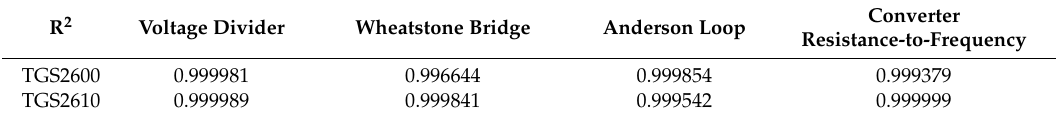
Table 2. Coe ffi cient of determination of model of each system.